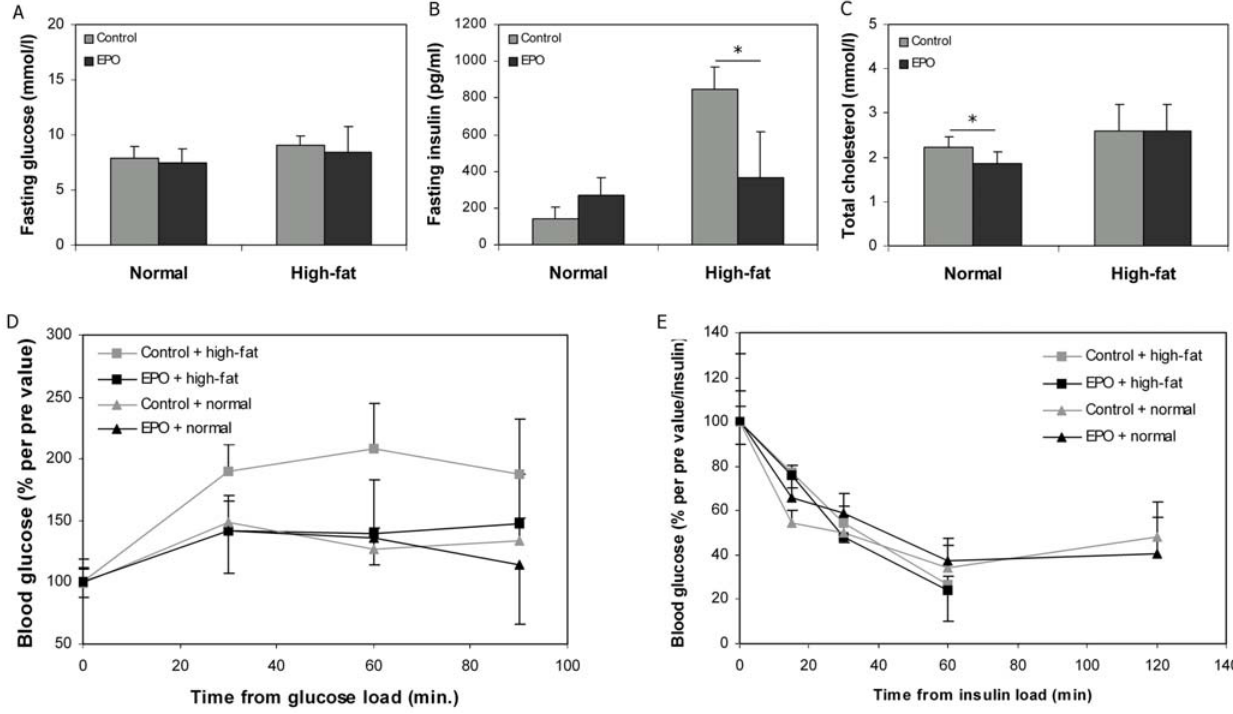
Figure 4. EPO improves glucose tolerance in high-fat fed mice. Twelve weeks after EPO electrotransfer A) fasting glucose, B) fasting insulin, and C) fasting total cholesterol were determined, and D) a glucose tolerance test and E) an insulin tolerance test were performed. Means 6 SEM for groups of 8 mice placed on either a regular chow or high-fat diet are depicted. Statistical significance was tested by Student’s t-test with Bonferroni corrections for multiple testing. * indicates significance at p , 0.05.